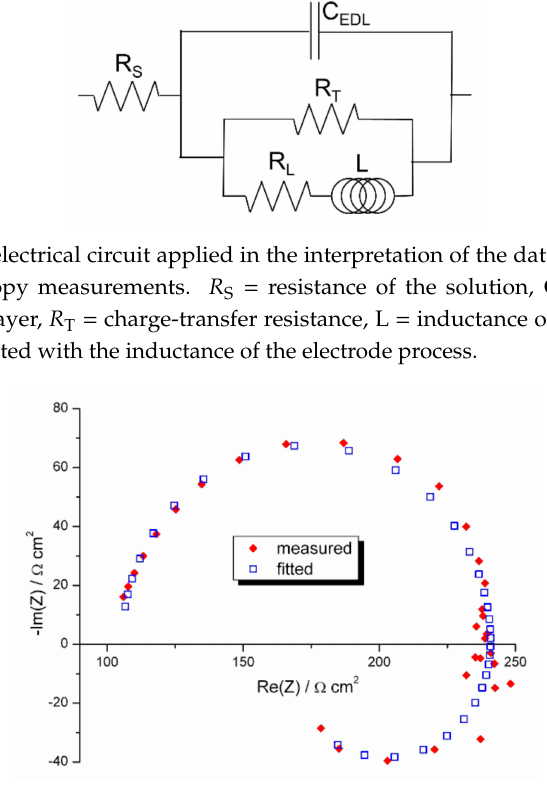
Figure 8. An example of the fit of the equivalent electrical circuit (EEC) showed in Figure 7 to the impedance data. Mg not subjected to any treatment (reference sample) in 0.15 mol dm –3 NaCl solution saturated with Mg(OH) 2